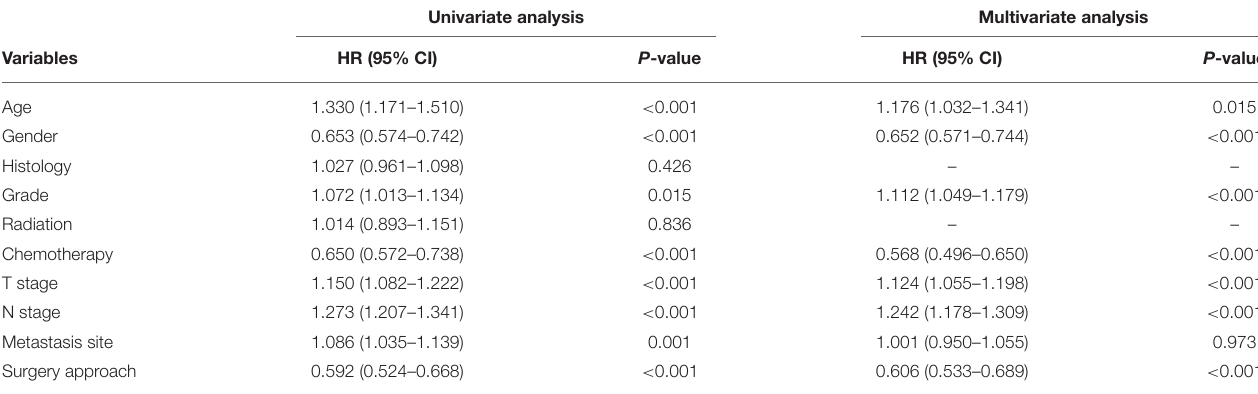
TABLE 4 | Univariate and multivariate analysis of clinicopathological characteristics for LCSS of the surgical patients. Univariate analysis